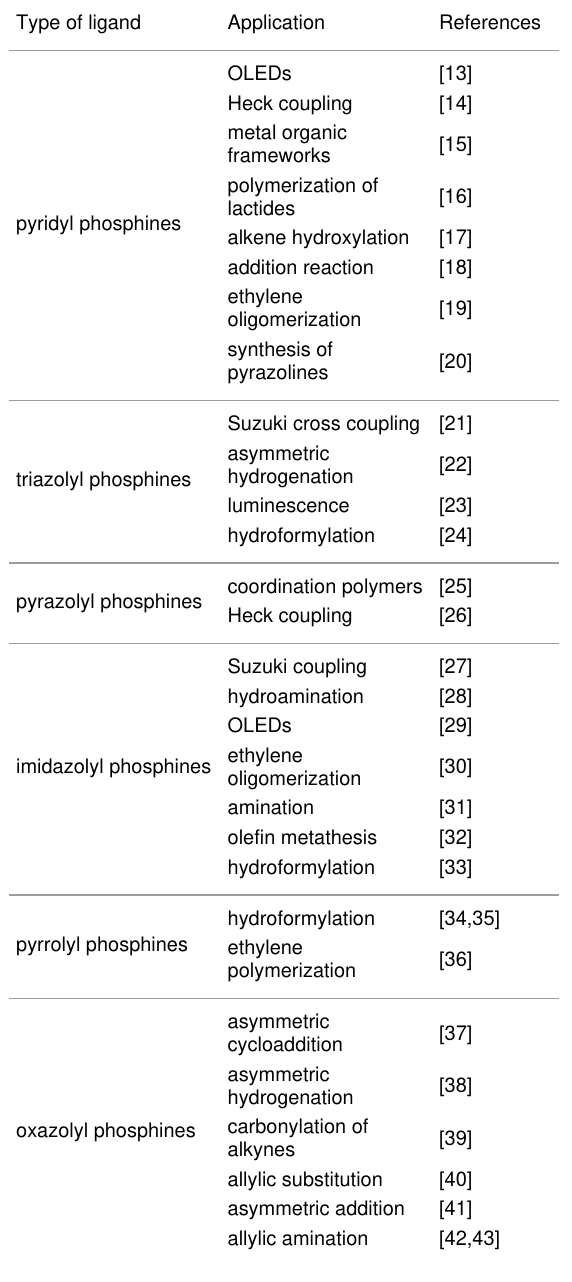
Table 1: Selected works on the applications of P,N-phosphine ligands.